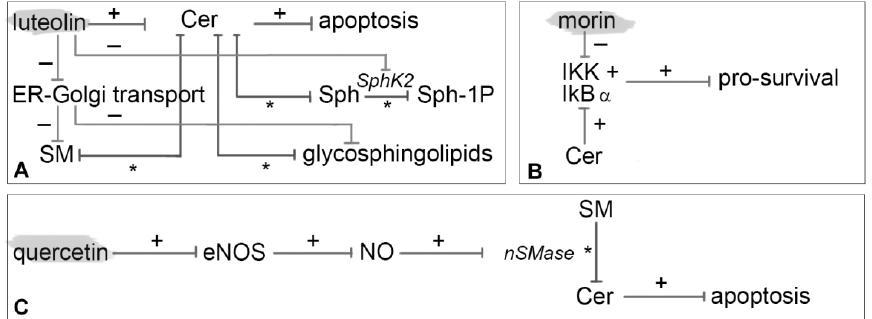
Figure 5. Mechanism of modulation on sphingolipids by luteolin (A), morin (B) and quercetin (C). It is depicted with an asterisk (*) enzymatic pathway, with plus (+) red-regulated pathway and with minus (−) down-regulation ones.